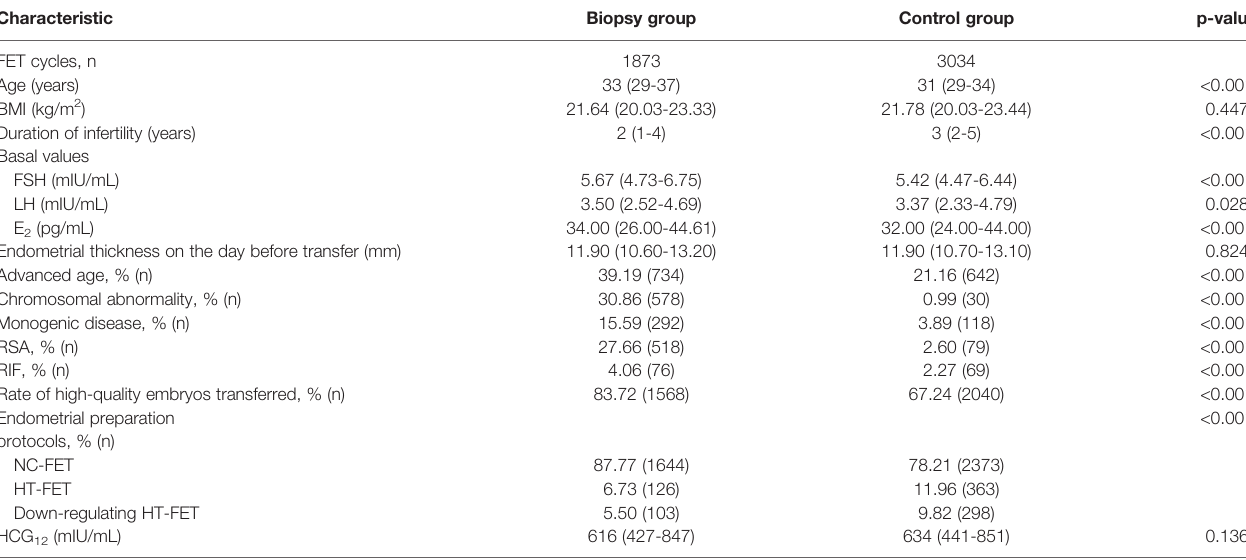
TABLE 2 | Baseline characteristics of cycles resulting in live